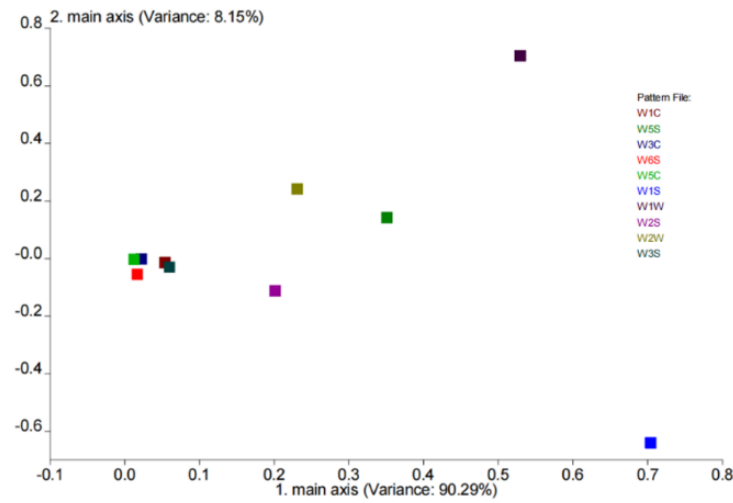
Figure 10. The loadings ’ analysis of different yogurt.